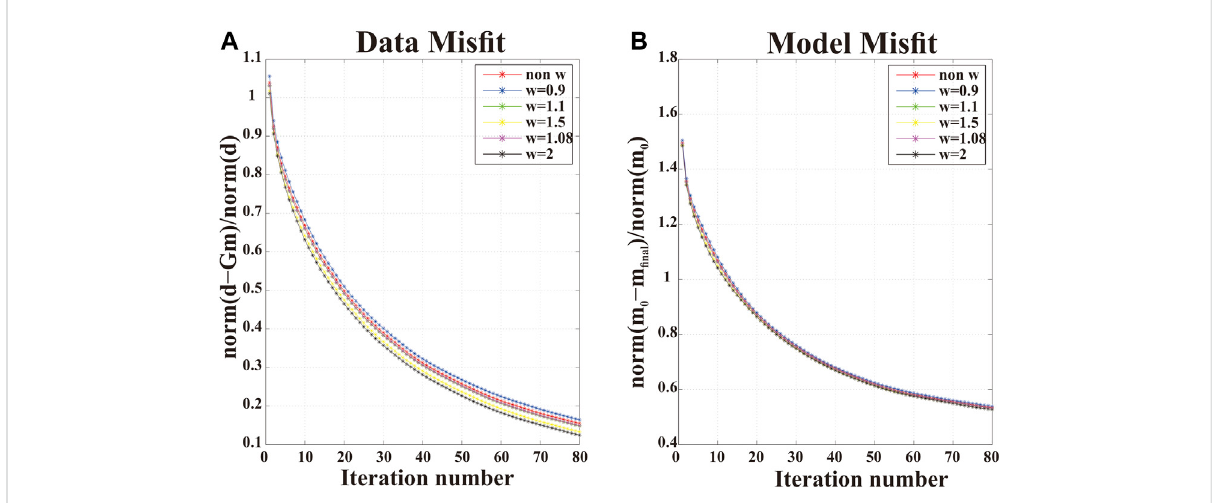
FIGURE 5 Curve of the data and model mis fi t with different values of ω . (A) The plot shows that the different values of ω have an impact on the inversion data convergence and (B) on the accuracy of the